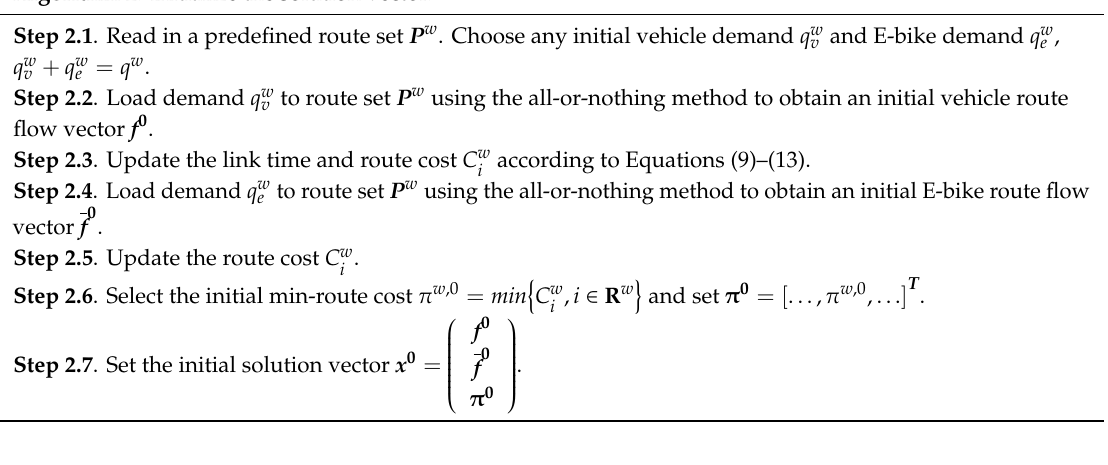
Algorithm 2 . Initialize the solution vector.